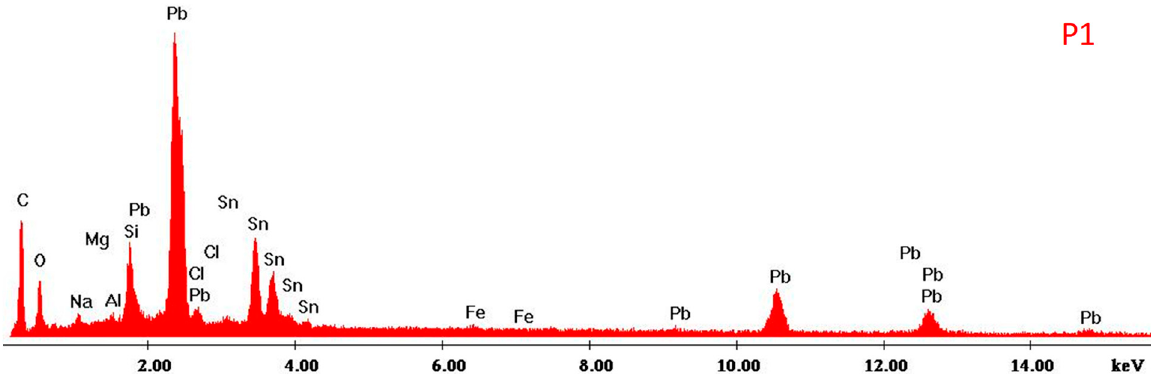
Figure 28. Clusters of micrometric subhedral crystals found in the matrices ( a , b ), mainly concentrated in the bands (DMS_2Bb yellow natron-based Egypt I tessera from the Great Mosque of Damascus—unpublished data [24,25]). These crystals often show the presence of greyish, lower average atomic number zones ( c , d ).